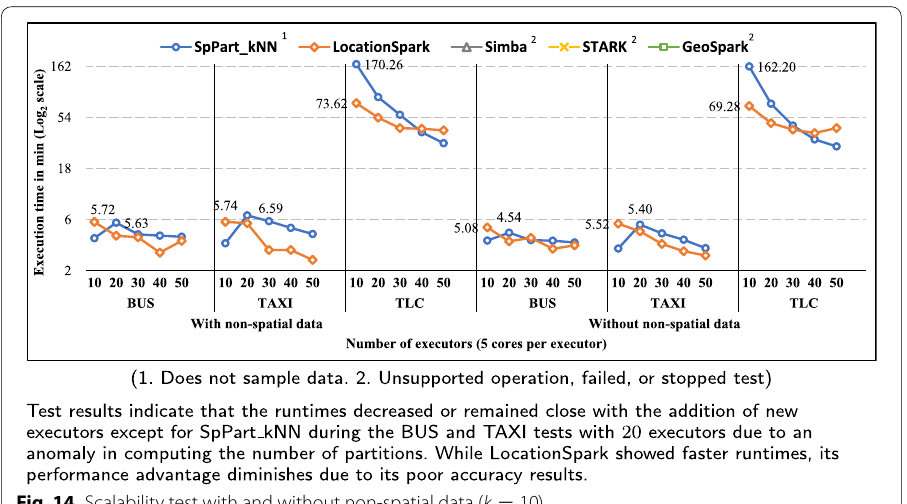
Fig. 14 Scalability test with and without non-spatial data ( k = 10